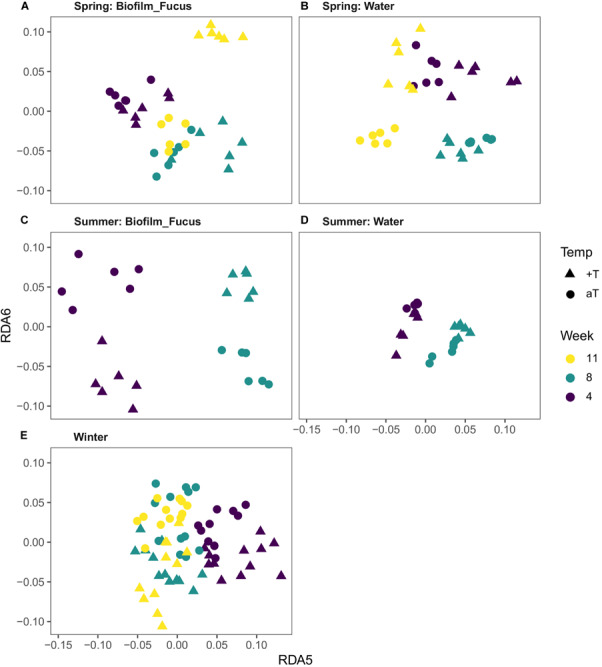
Visualization of the temperature effect on bacterial communities. Distance plots were derived from respective RDA models (see “Materials and Methods” section). Since the temperature effect is rather subtle, higher dimensions (constrained axes “RDA 5” and “RDA 6”) were chosen to achieve optimal visual differentiation between temperature treatment groups (Temp; aT, ambient temperature; +T, increased temperature). In spring (A,B) and summer (C,D), the difference in community composition depends on the origin of the bacterial communities (“Biofilm_Fucus” or “Water”) as well as on the duration of the treatment (Week; note the different directions in which the groups are separated). In winter (E), samples are uniformly separated according to temperature treatment, regardless of duration and origin.